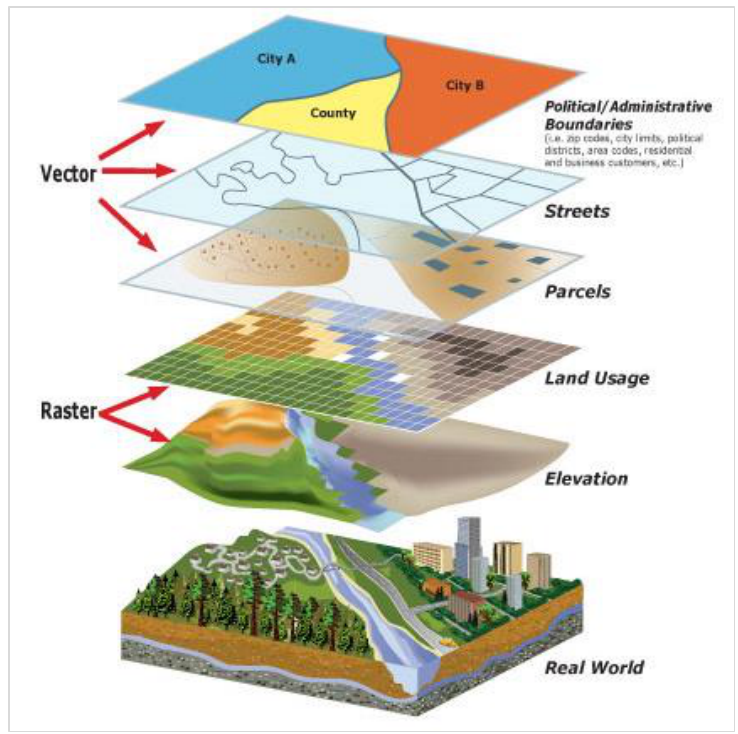
Figure 2. GIS model layers of the real world